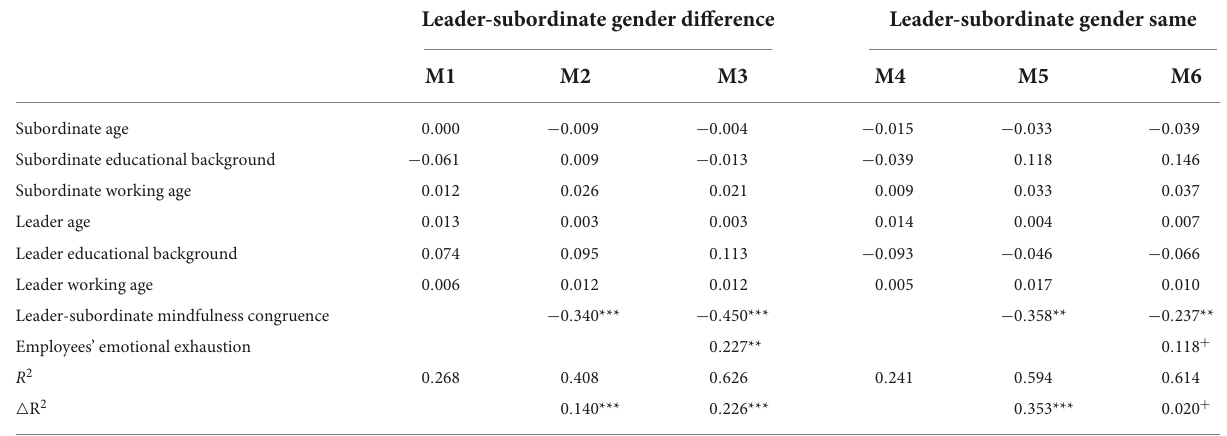
TABLE 5 Moderating effect test of leader-subordinate gender